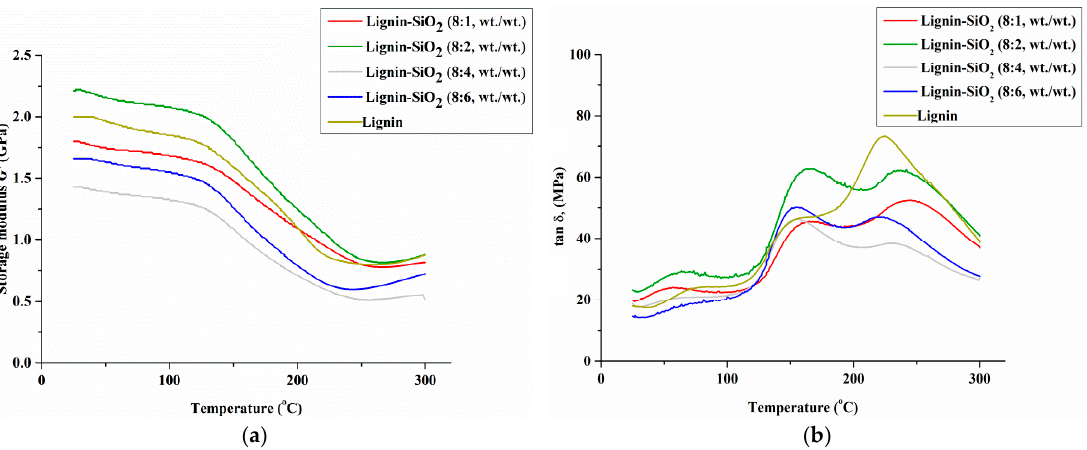
Figure 4. Dynamic mechanical storage modulus G’ ( a ) and tan δ ( b ) versus temperature for composites consisting of 80% abrasive grains and with filler (lignin, silica or lignin–silica hybrids). Table 4. Values of storage modulus G’ and glass transition temperature Tg for composites based on lignin–silica hybrids and pure lignin. Sample G’ 25 ˝ C